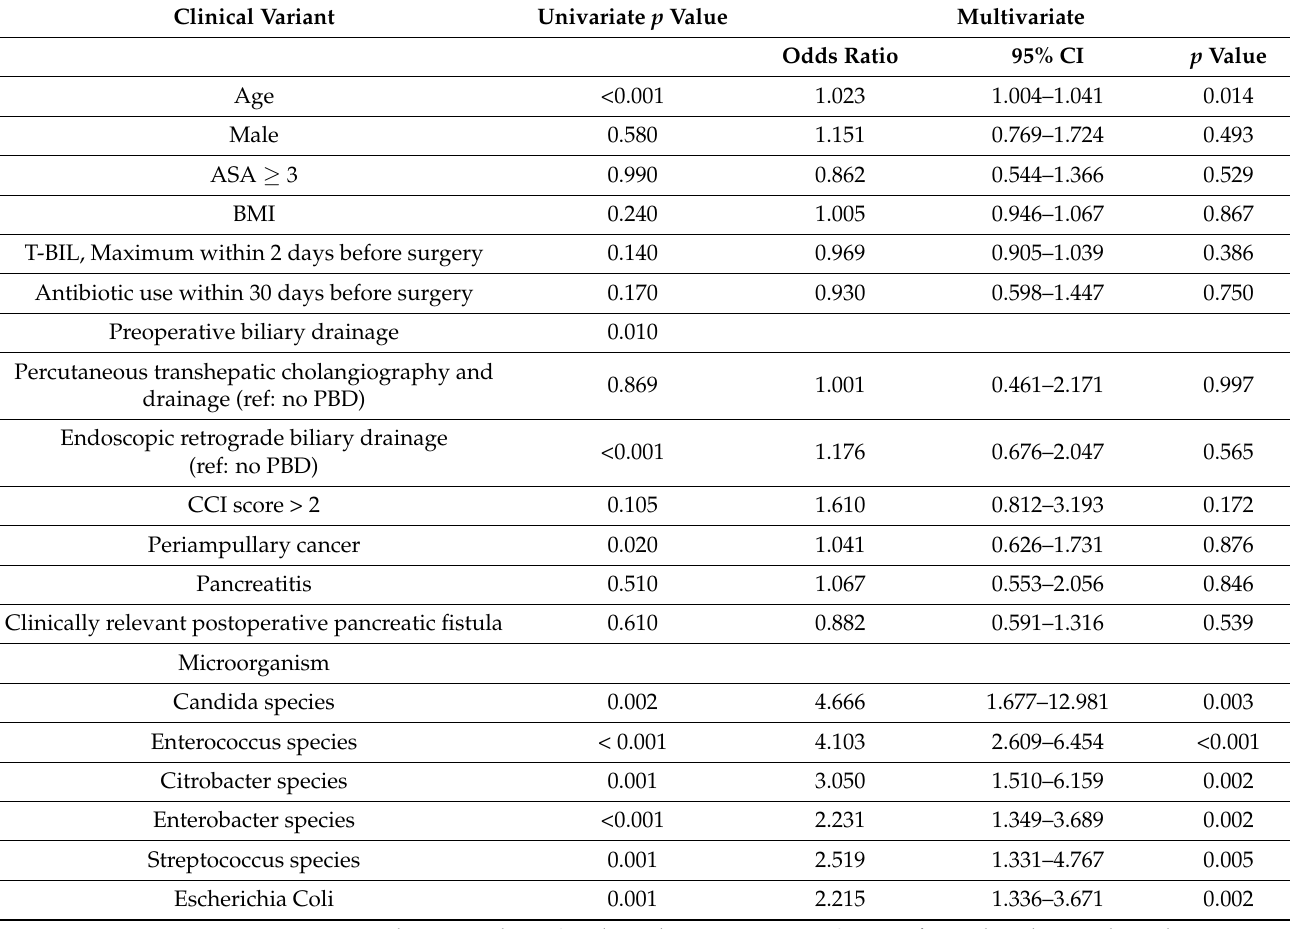
Table 3. Univariate analysis and adjusted multivariate analysis to predict intra-abdominal